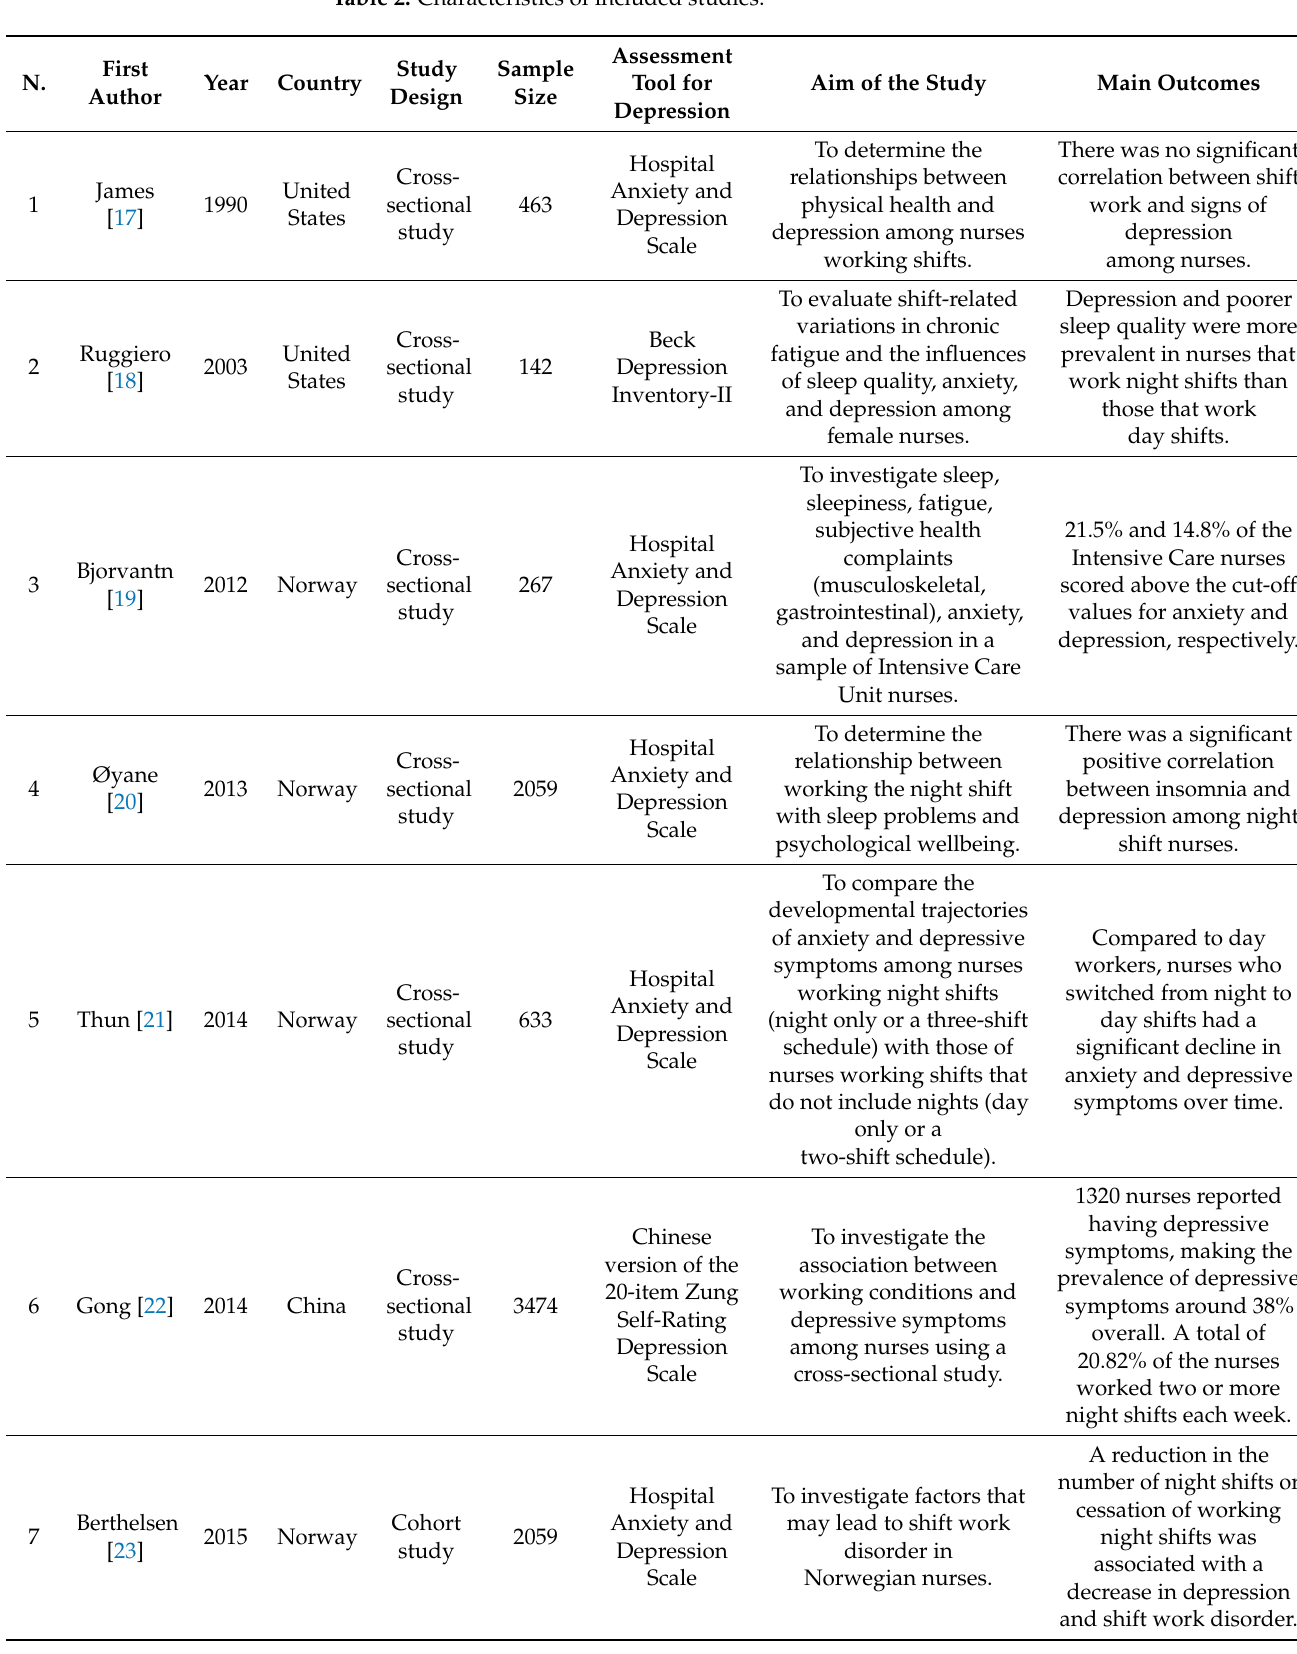
Table 2. Characteristics of included